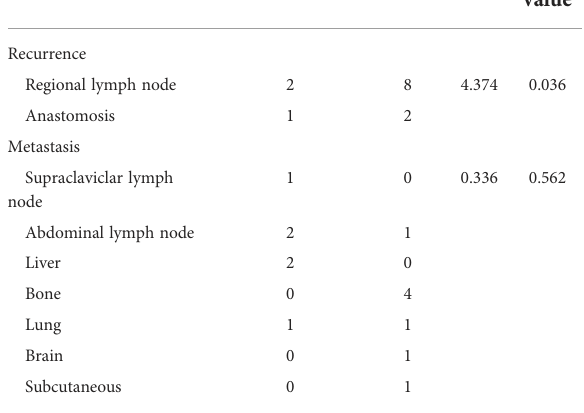
TABLE 6 Failure modes after radical